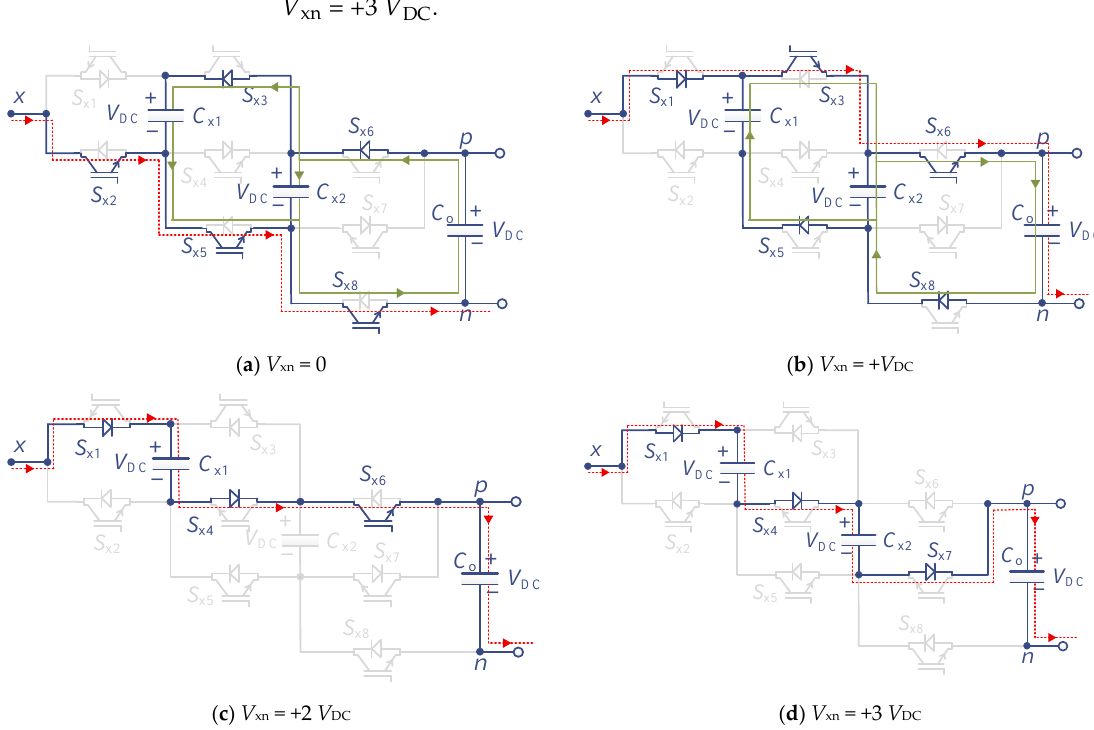
Figure 5. Switching states of the proposed